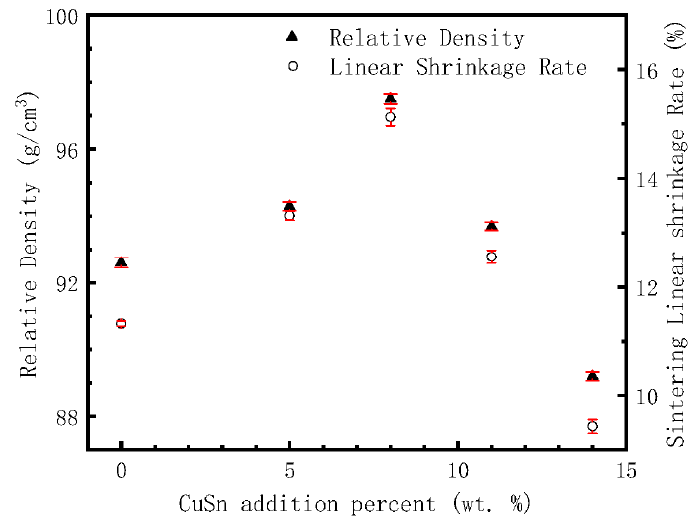
Figure 2. The relations between the relative density and the linear shrinkage rate of sintered alloys to Cu-Sn addition percent. two phases [26,27]. As a Sn atom has large solid solubility in the Cu phase at elevated temperatures, it will not form a new phase alone. It can be seen from Figure 1 that there are large-sized Cu-rich phase aggregate grains in the alloys with Cu-Sn added. The grains of Cu-rich phase in alloy with 8 wt.% Cu-Sn addition are slightly coarser than in other alloys, indicating the process of Cu atom aggregation and diffusion is more complete, thus obtaining higher density. Figure 3 shows the XRD diffraction patterns of studied alloys, which indicates that the phase composition of the studied alloy is mainly α -Fe and Cu-rich phase.